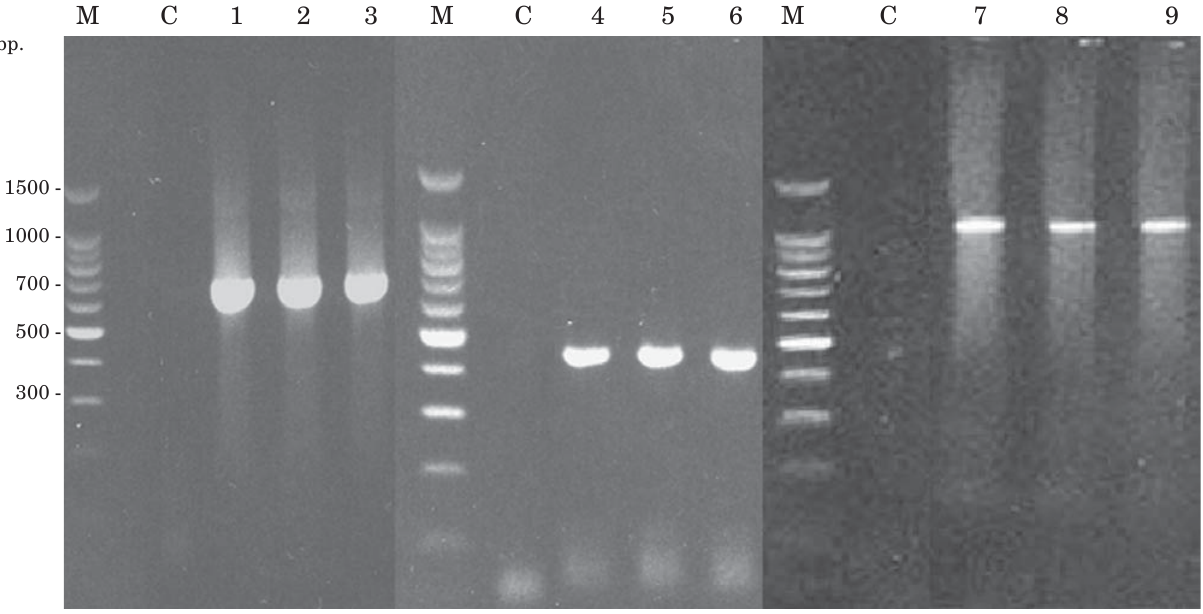
Fig. 1. DNA amplification products (670, 420, and 1200 bp) of Meloidogyne javanica , M. arenaria , and M. incognita using species-specific SCAR-PCR primer pairs (Fjav/Rjav, Far/Rar, and Finc/Rinc respectively). Lanes 1–3, M. java- nica isolates (4–6); lanes 4–6, M. arenaria isolates (26–28); lane 7–9, M. incognita populations (15–17); lane C, water control; lane M, 100 bp-DNA